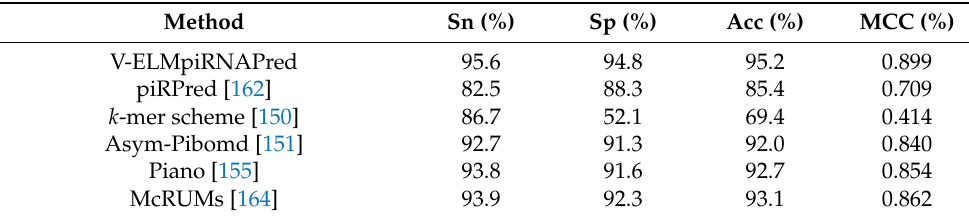
Table 5. Comparison of the performance of V-ELMpiRNApred with earlier methods.